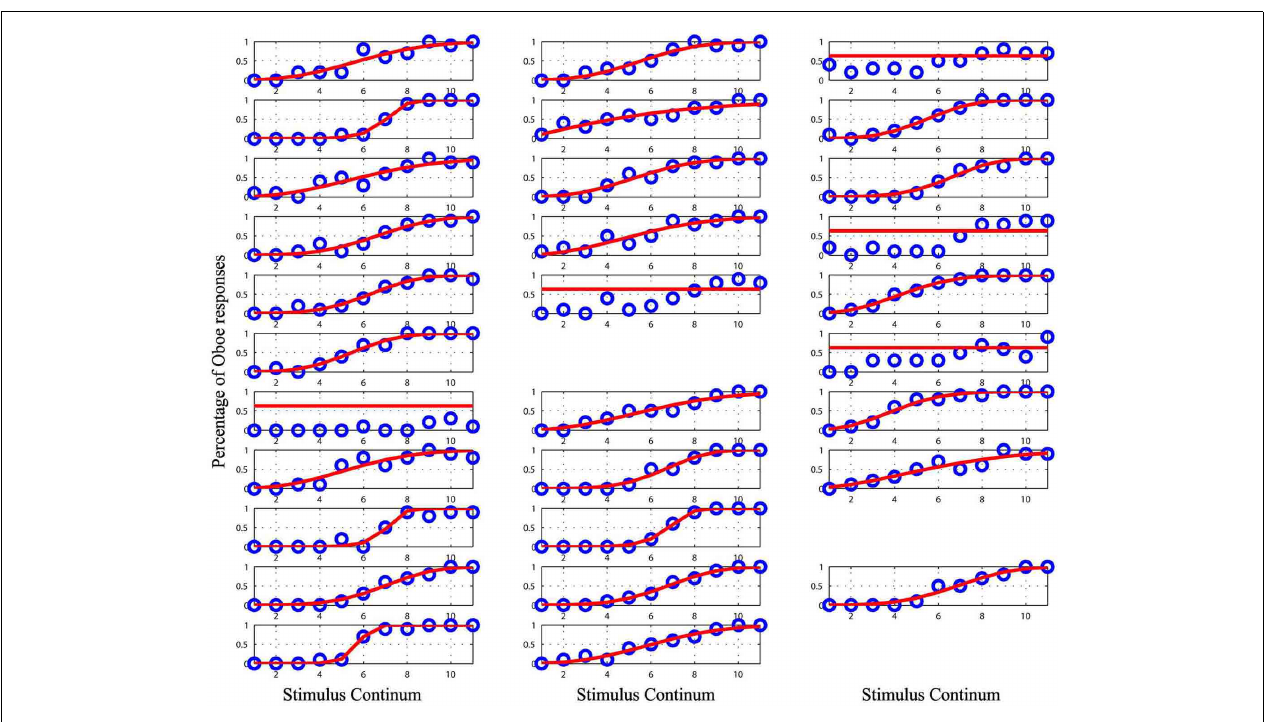
FIGURE 2 | Plot of the raw data (blue circles) and the cumulativeWeibull function (red lines) for each subject in the bass clarinet/oboe condition. Empty spaces mark missing data for subject 17, 27, and 33. Data from the subject 3, 12, 14, 18, and 19 were removed from the analyses as they could not be modeled.